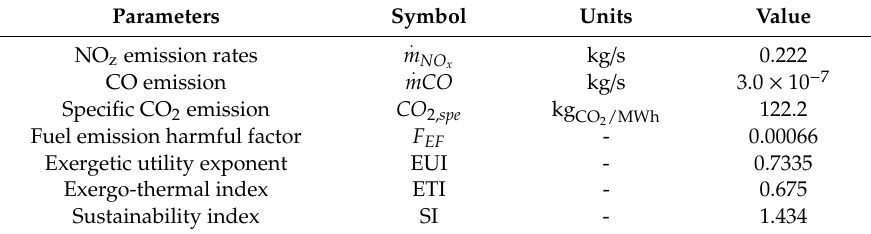
Table 4. Environmental and sustainability parameters.